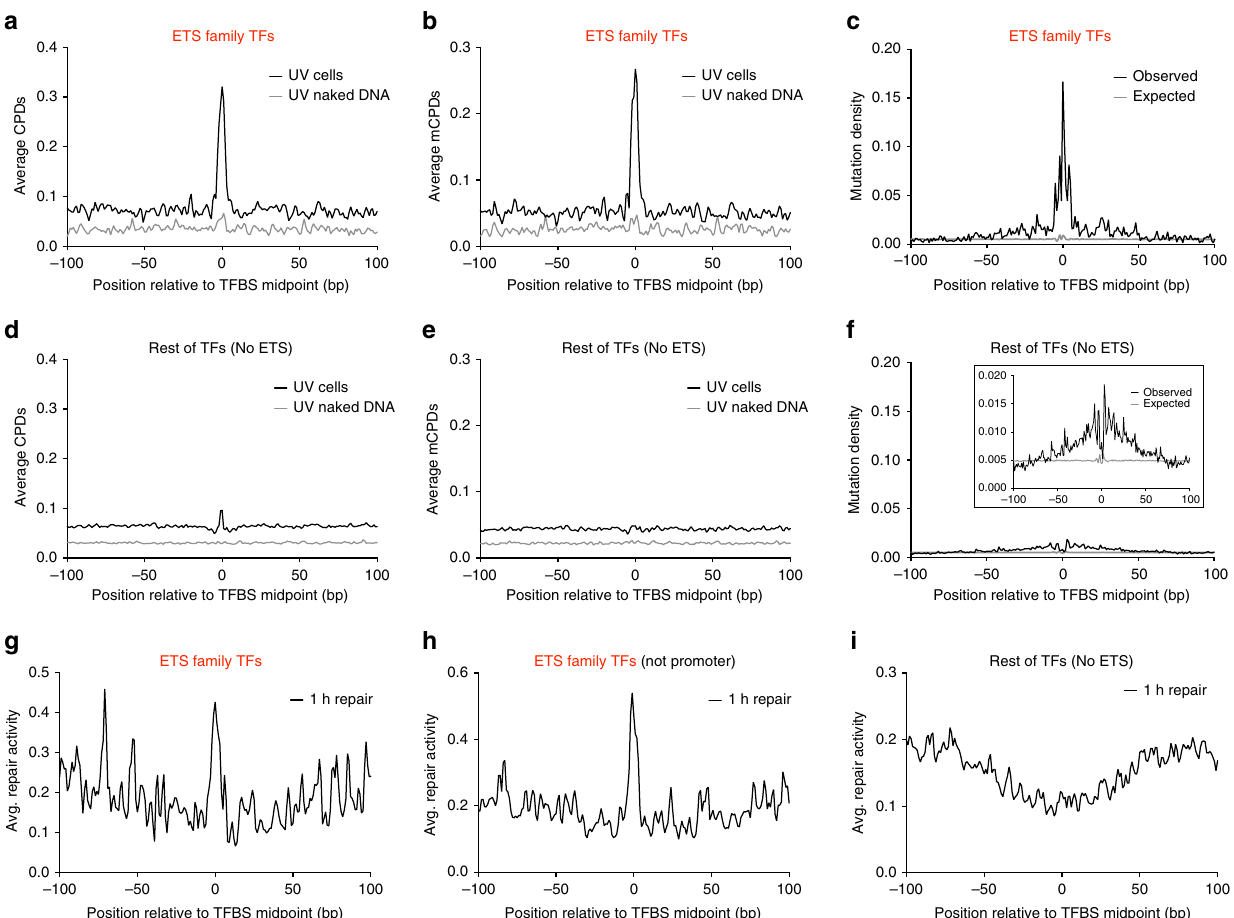
Fig. 3 ETS family TFBS are the primary contributors to elevated CPD levels. a, b Formation of CPD ( a ) and mCPD ( b ) lesions is signi fi cantly stimulated at active, promoter-proximal ETS family TFBS (i.e., ELF1, ELK4, ETS1, and GABPA) in UV-irradiated NHF1 cells, but not when isolated NHF1 DNA was UV- irradiated in vitro (naked DNA). c Mutation density is signi fi cantly elevated at active promoter-proximal ETS family TFBS (i.e., ELF1, ELK4, ETS1, and GABPA) in melanoma tumors, correlating with the higher initial mCPD lesion density at these sites. d, e Formation of CPD ( d ) and mCPD ( e ) lesions is not signi fi cantly stimulated at active promoter-proximal TFBS after excluding ELF1, ELK4, ETS1, and GABPA binding sites. f Mutation density is only slightly elevated surrounding non-ETS family TFBS in aggregate (see inset with expanded scale). Only active promoter-proximal TFBS were analyzed. g CPD repair activity is elevated at ETS family TFBS following UV irradiation of human cells. Average CPD repair activity at 1 h repair in UV-irradiated NHF1 cells at ETS family TFBS (i.e., ELF1, ELK4, ETS1, and GABPA). CPD repair activity was calculated using the average number of XR-seq reads 5 at locations surrounding active, promoter-proximal ETS binding sites. XR-seq reads were localized to the putative dipyrimidine lesion associated with each sequencing read. h Same as in g , except repair activity for active ETS family TFBS located outside promoter regions was analyzed. i Same as ( g ), except CPD repair activity